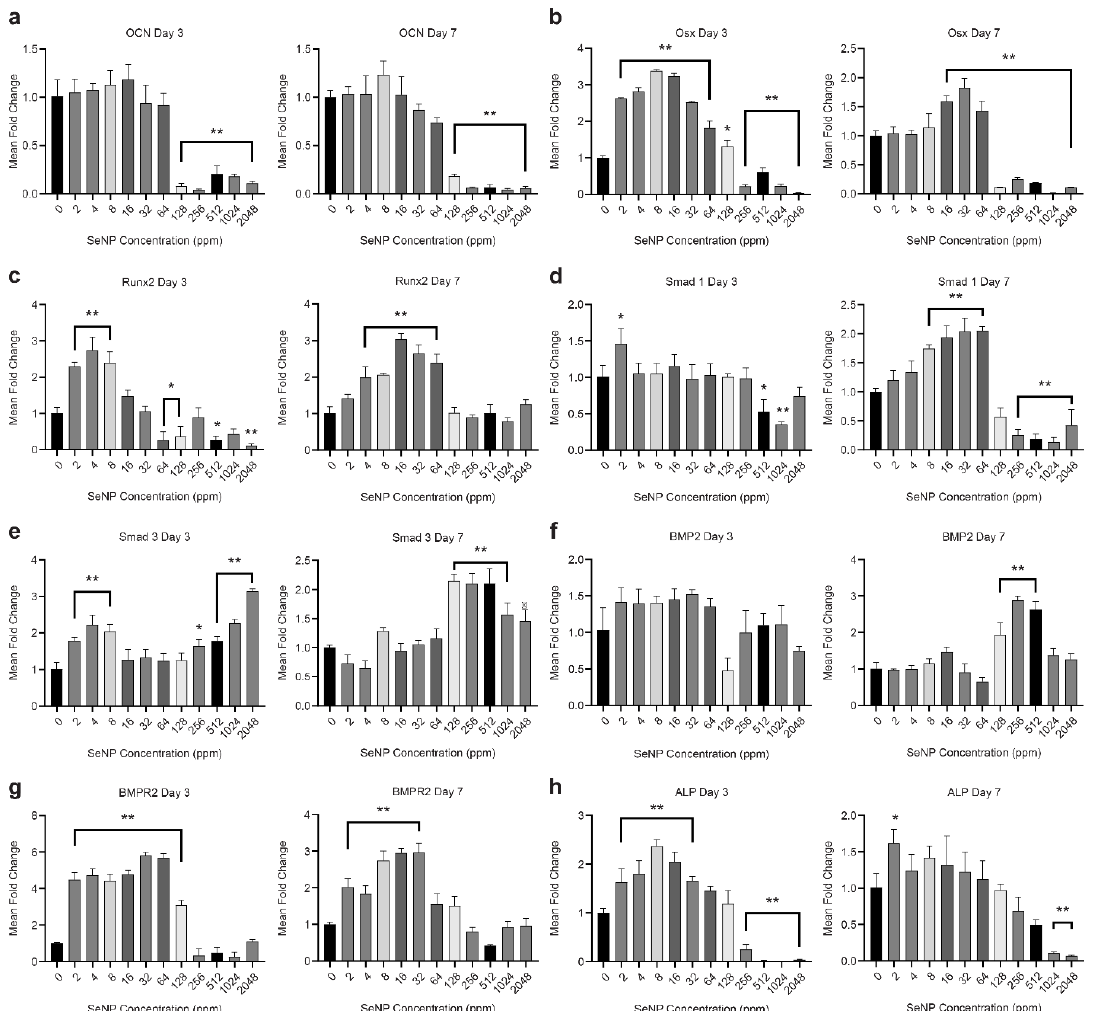
Figure 4. Gene expression analysis using reverse transcriptase quantitative polymerase chain reaction on days 3 and 7. The expression levels of the tested gene markers were normalized based on hypoxanthine-guanine phosphoribosyl transferase (HPRT) expression. Primer used in the analysis are as follows: ( a ) osteocalcin, ( b ) osterix, ( c ) runt-related transcription factor 2, ( d ) Smad 1, ( e ) Smad 3, ( f ) bone morphogenetic proteins 2, ( g ) bone morphogenetic proteins receptor 2, and ( h ) alkaline phosphatase. Data are expressed as mean ± standard deviation, n = 3. (*: p < 0.05, **: p < 0.01).